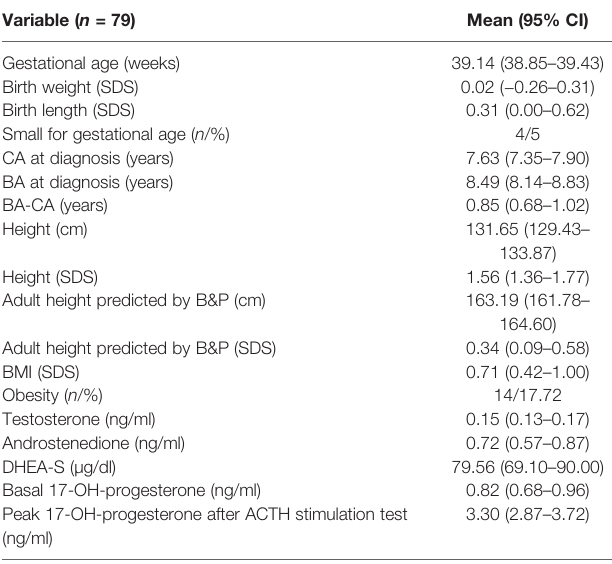
TABLE 1 | Neonatal demographic and anthropometric data. Demographic, anthropometric, and biochemical data at